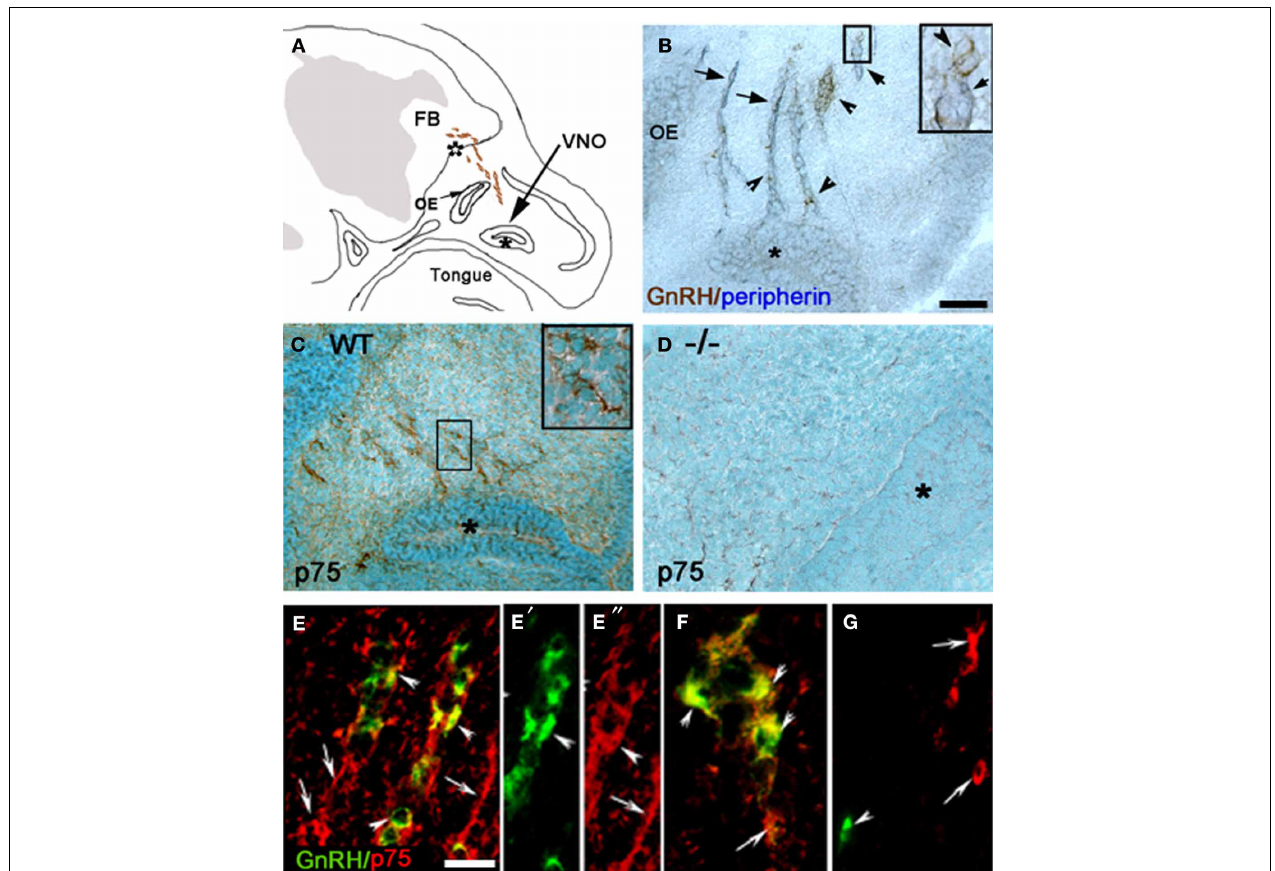
FIGURE 1 | GnRH neurons express p75NGFR. (A) Camera lucida drawing of an E12.5–E14.5 mouse head showing the localization of GnRH neurons (brown dots) in the nasal region. (B) Sagittal section from an E12.5 mouse immunostained for GnRH (brown, arrowhead) and peripherin (blue, arrow; insert = higher magnification of boxed region). Both cells and fibers are detected leaving the vomeronasal organ (VNO, marked by asterisk). (C) Immunostaining for p75NGFR (p75, brown) spatially overlapped with GnRH neurons and olfactory fiber tracks/pathways. (D) Sagittal section from an E16.5 p75NGFR mutant embryo ( − / − ) stained with the p75NGFR antibody. No p75NGFR staining was observed. (E–E (cid:3)(cid:3) ) Double-labeling for GnRH (green) and p75NGFR (red) showed that the majority of migrating GnRH